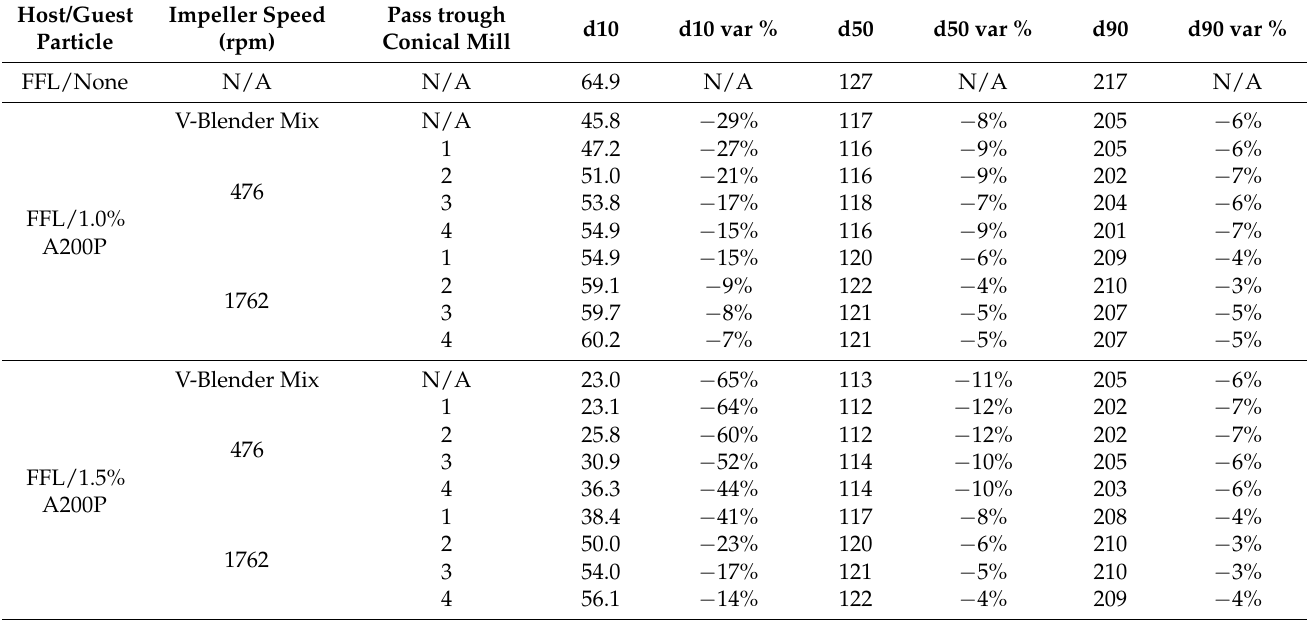
Table 3. FFL particle size distribution results of the continuous mode